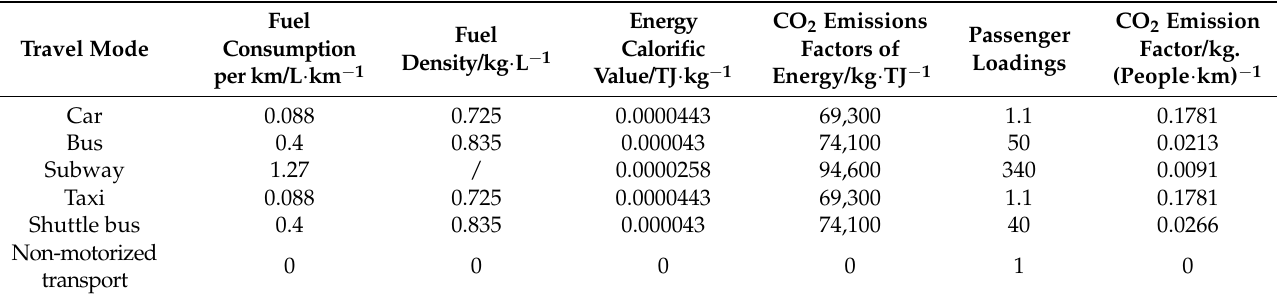
Table 1. CO 2 emission factors of various transport